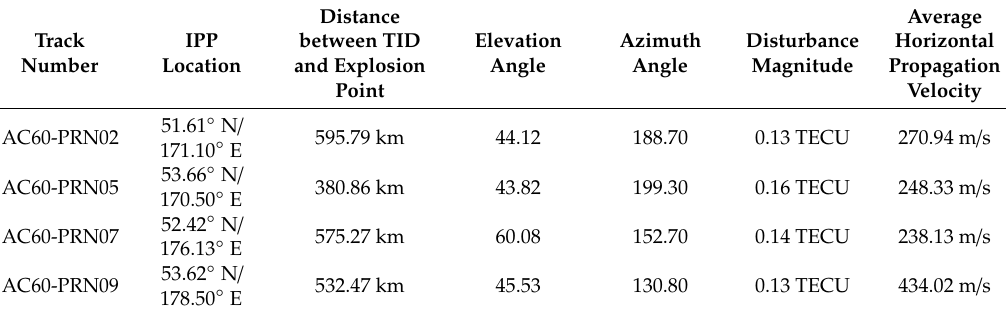
Figure 7. Spatial distribution of the TEC disturbance. The black arrow in the figure points to the TID position. The red five-pointed star is the location of the meteor explosion. Table 1. TID spatial distribution characteristic